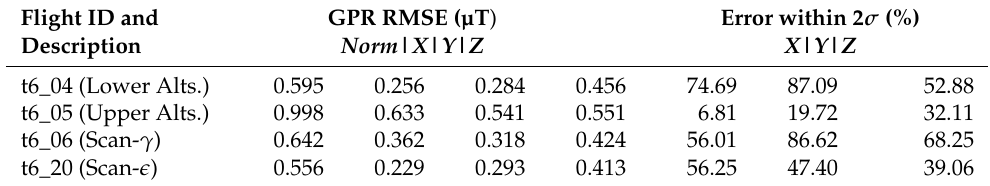
Table 2. Multi-altitude map error. Trained on n 2 = 408 observations from flight test t6_21 (Scan- (cid:101) ⊥ ). Flight ID and GPR RMSE (µT ) Error within 2 σ (%)